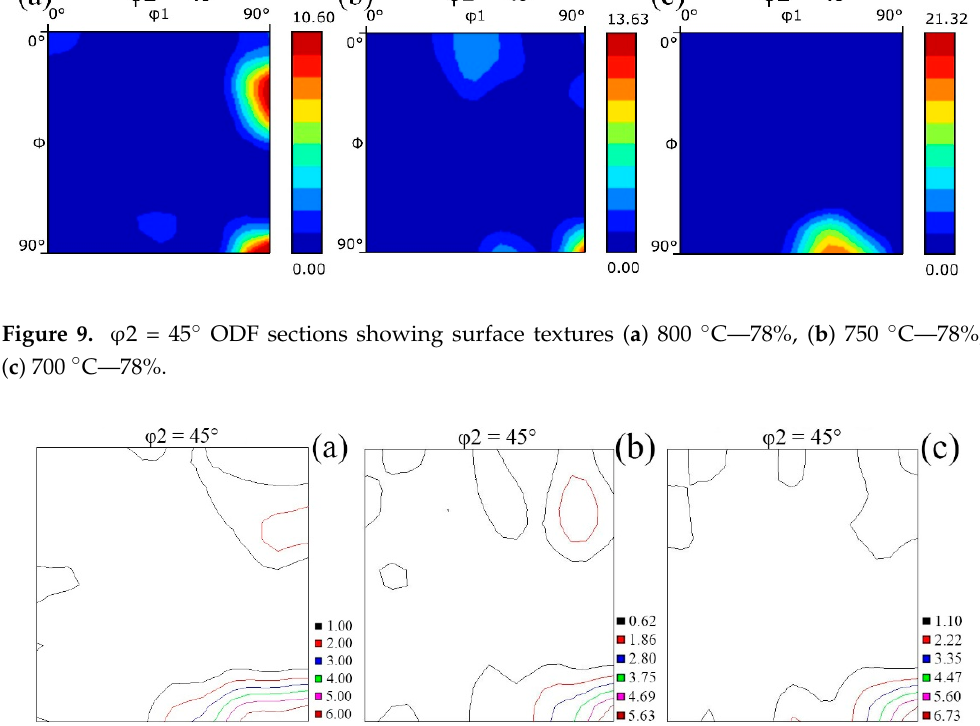
Figure 10. Macro-texture ( φ 2 = 45° section of ODF) of samples rolled with different reduction rates